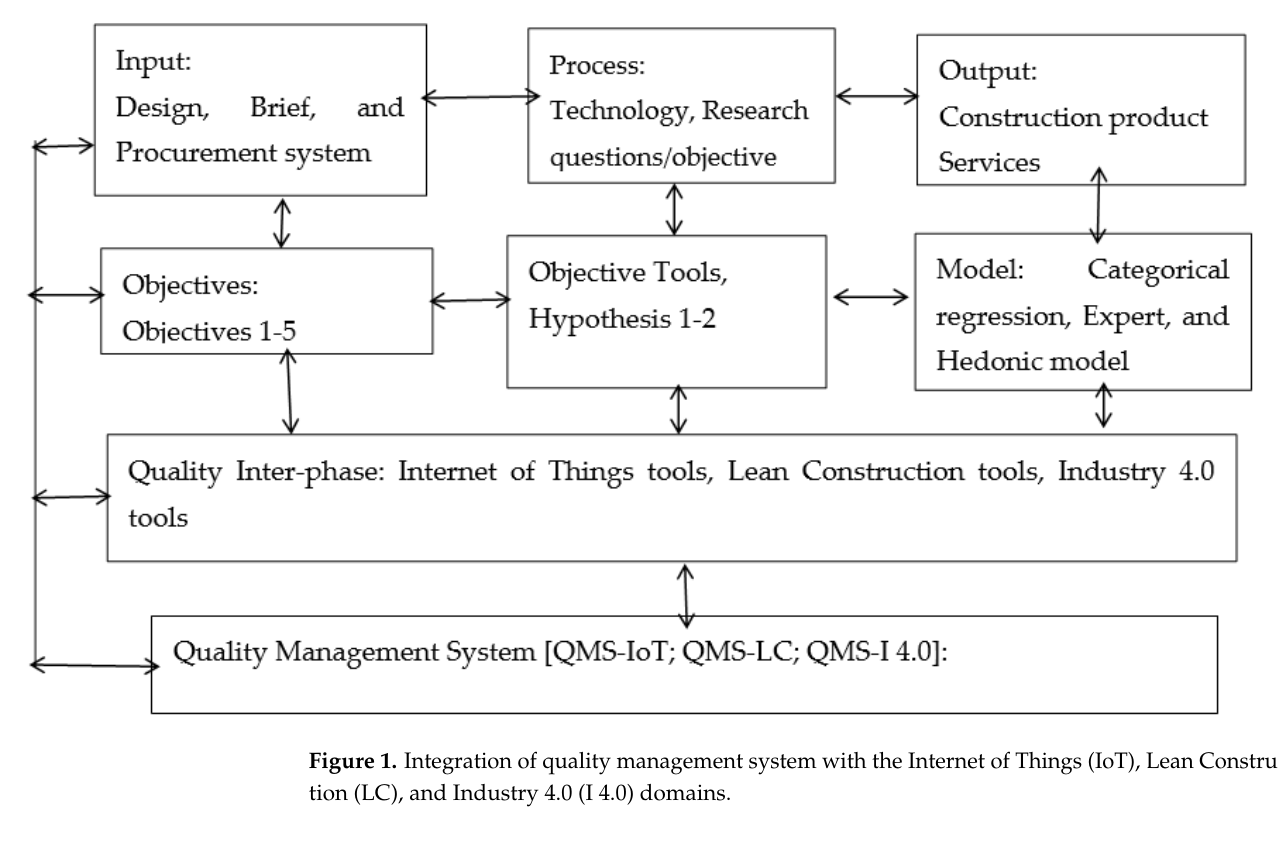
Figure 1. Integration of quality management system with the Internet of Things (IoT), Lean Construction (LC), and Industry 4.0 (I 4.0) domains.